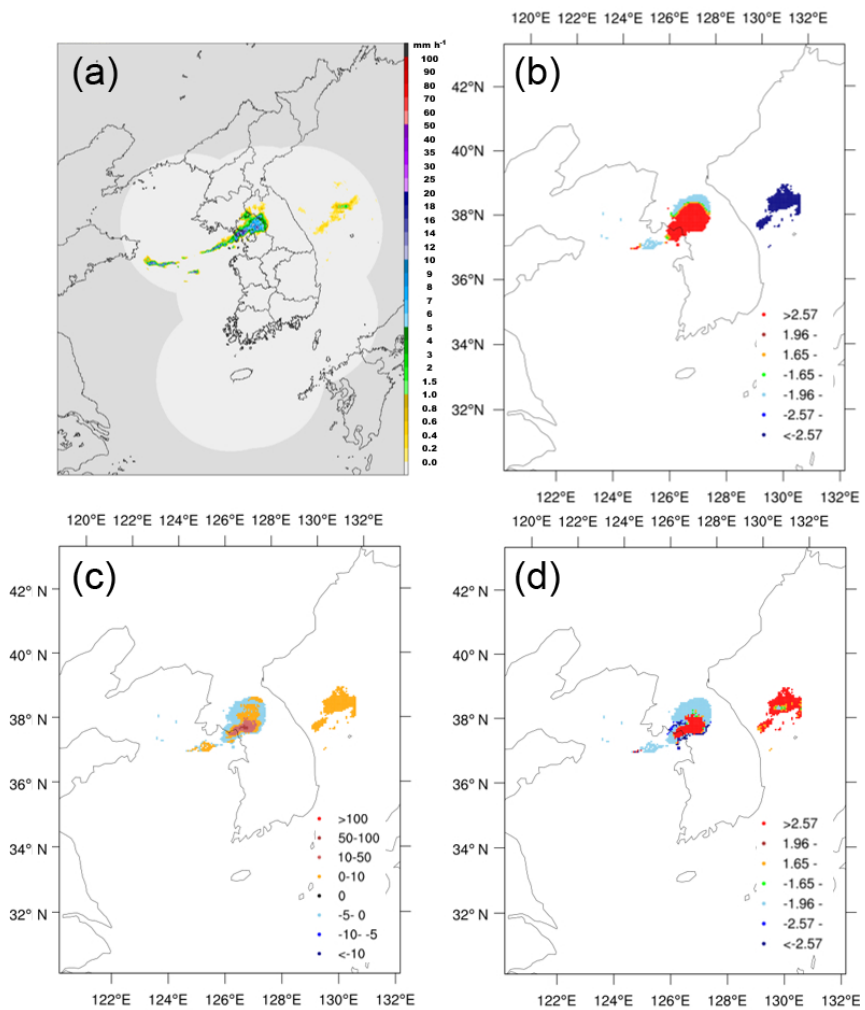
Figure 11. Same as in Fig. 9 but for an HPFP case at 05:00KST on 24 October 2015 and the computational domain of 37.14–39.06 ◦ N and 123.32–131.21 ◦